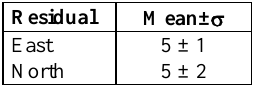
Table 1. Horizontal residuals in